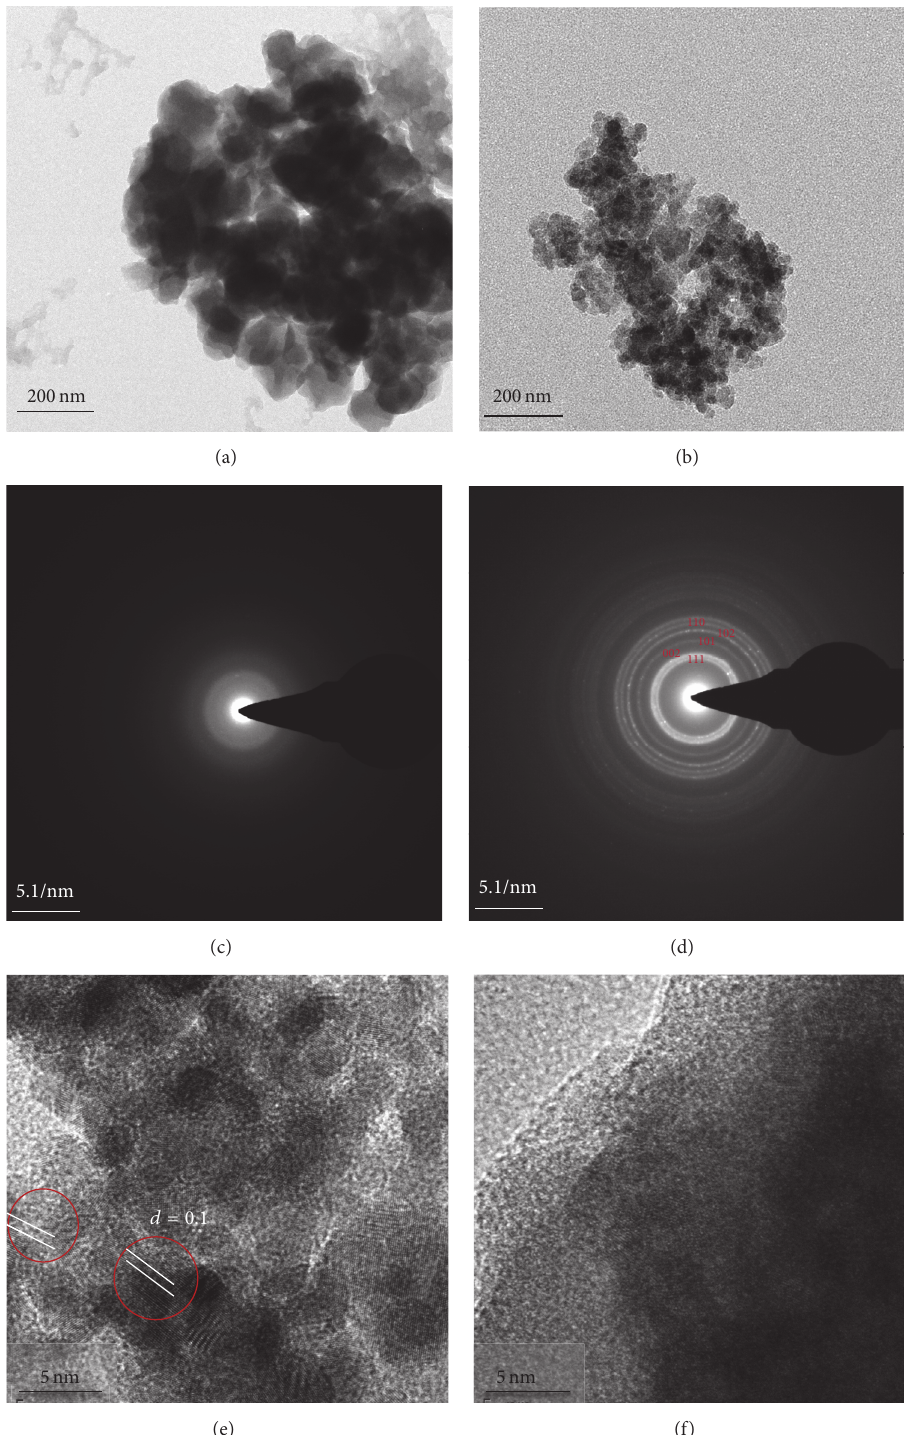
Figure 1: HRTEM analysis for ZnO nanoparticles sample (a–f) TEM